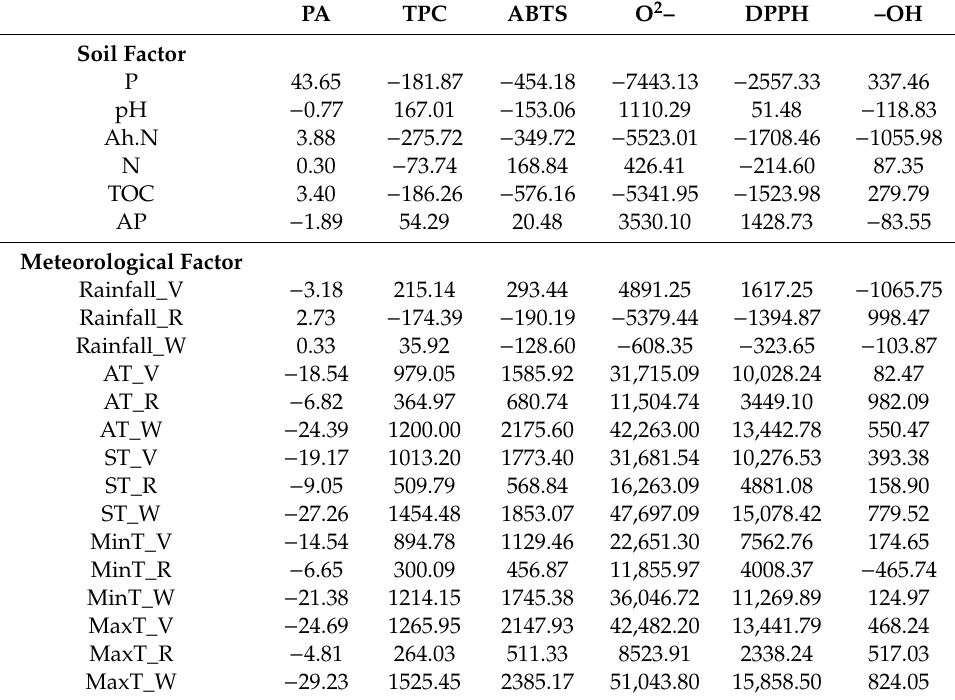
Table 5. Mean product between bioactive compounds contents, antioxidant capacities, and environmental